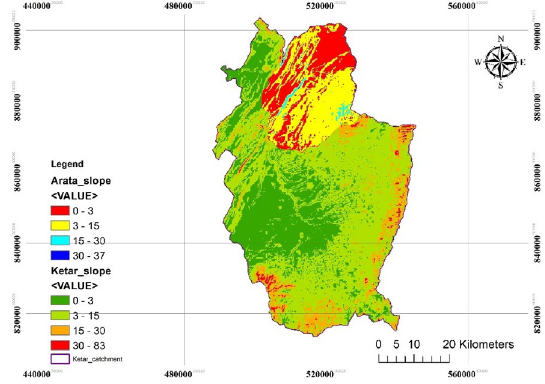
Fig. 5 Slope pattern of Arata and Ketar